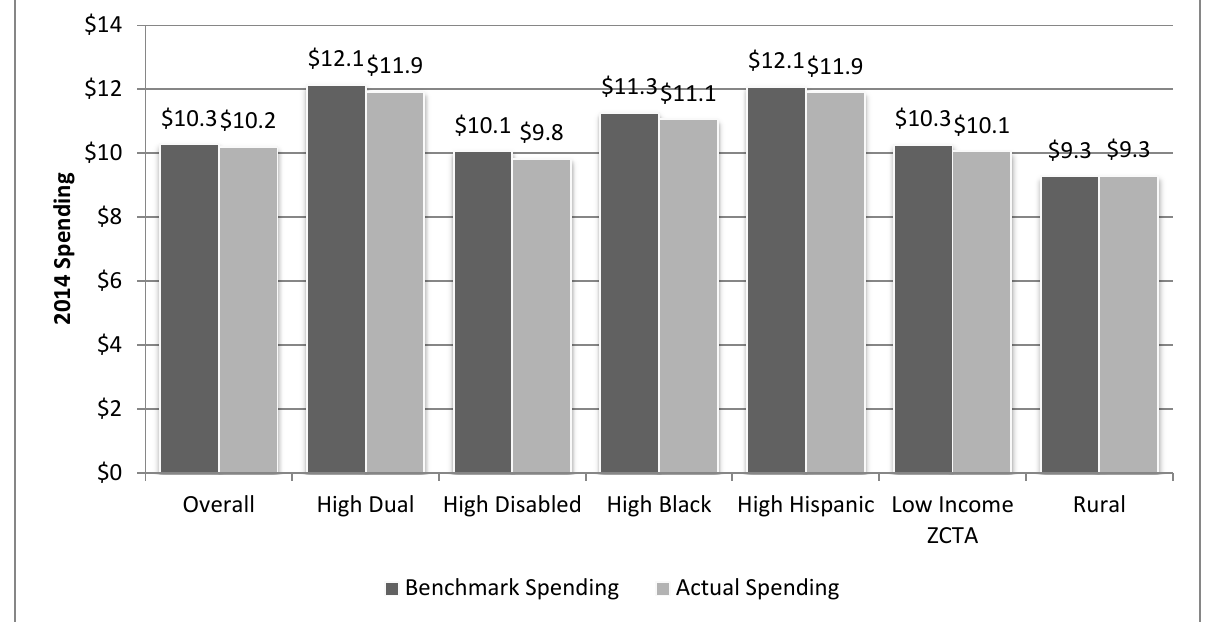
Figure 9.4: Per-Beneficiary Benchmark vs. Actual Spending by ACO Social Risk, 2014 (thousands of